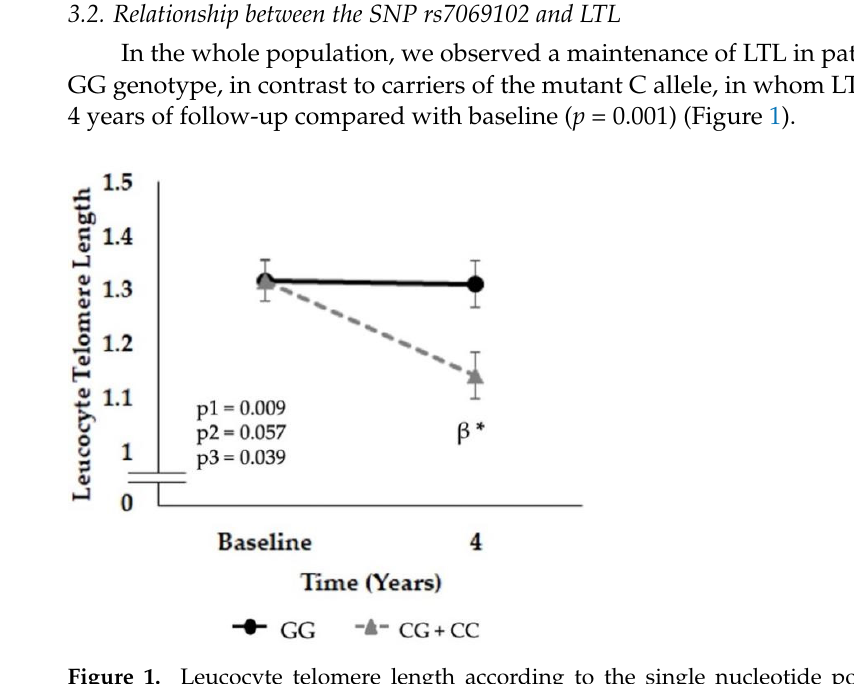
Table 1. Characteristics of patients according to genotype for SIRT1 polymorphism rs7069102 and diet.